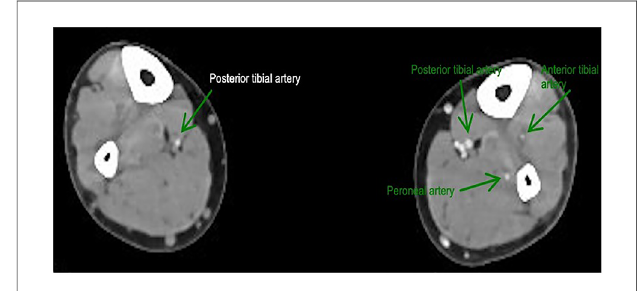
and blackish discoloration of the fi rst and fourth toes.